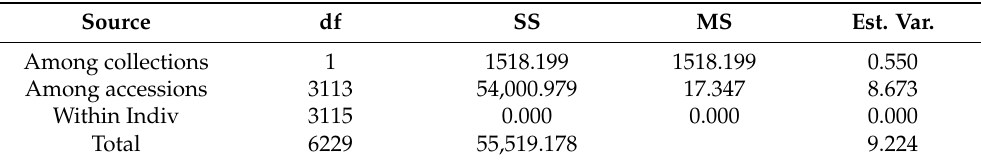
Table 5. AMOVA statistics of 10% core safflower accessions from model-based (43 varieties) popu- lations.